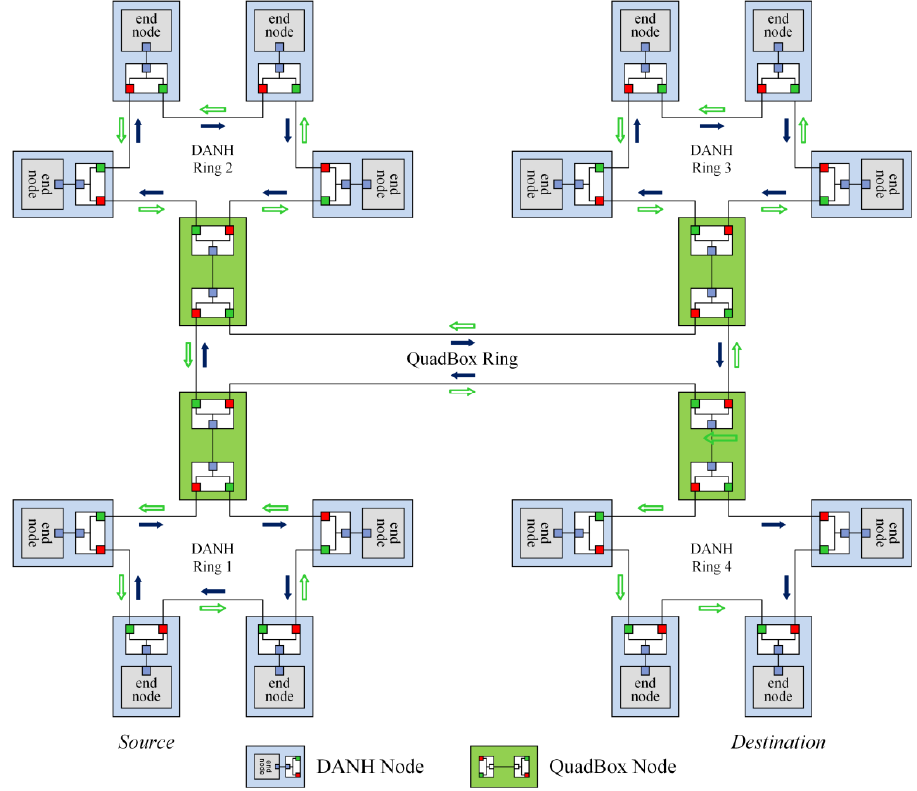
Figure 3. HSR example of connected-ring topology for unicast